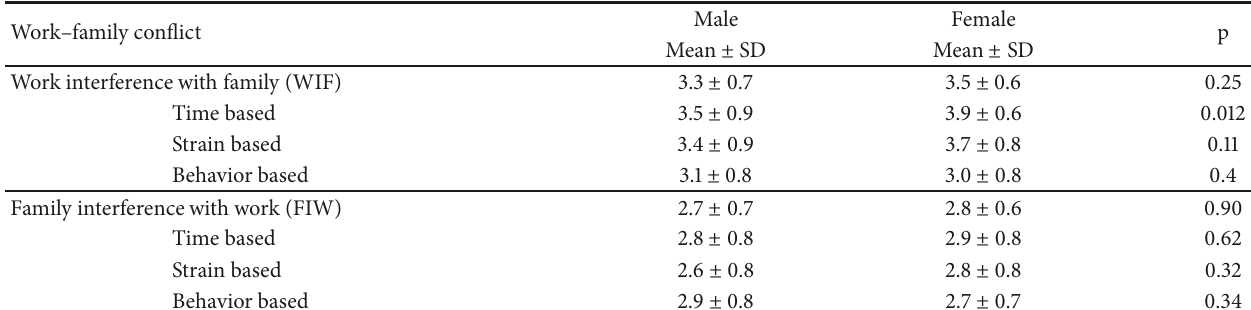
Table 5: Gender and work–family conflict in emergency physicians.